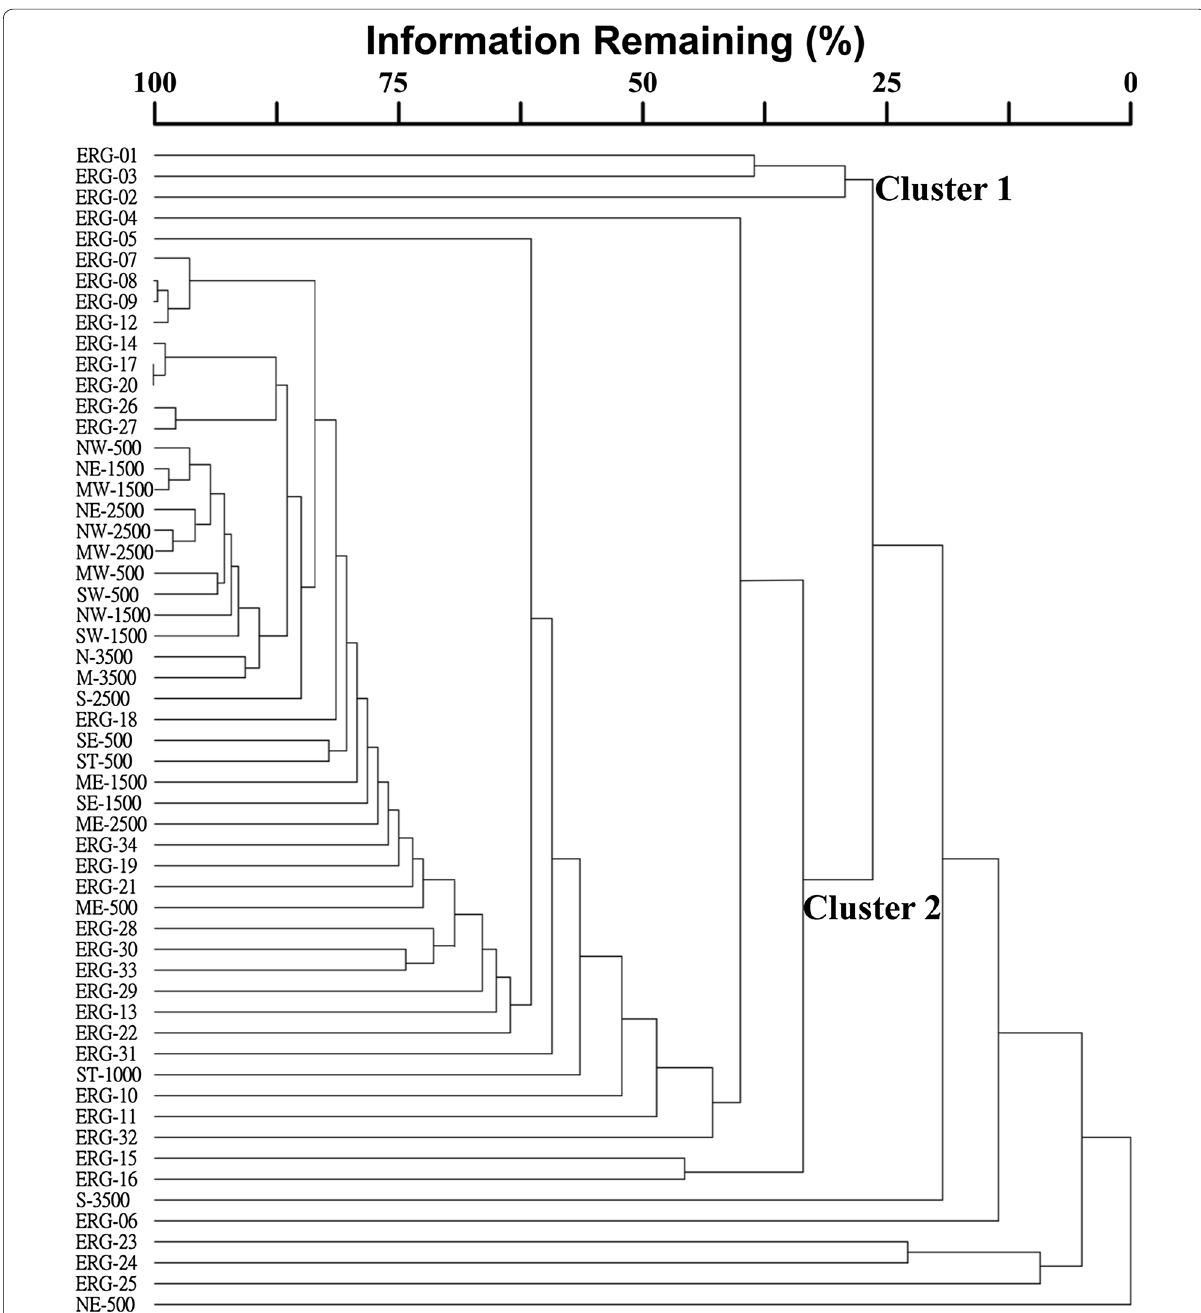
Fig. 4 Floristic relationships between 22 geographical localities of Taiwan (GLT) and 34 ecoregions in Asia were analyzed by cluster analysis, using simple nearest neighbor algorithm and Bray–Curtis dissimilarity method. Non‑endemic angiosperm species in Taiwan (NEAST) were used for the cluster analysis. The ecoregions of cold winter desert and temperate needle‑leaved forests were the first cluster and came out as the most deviating regions. The second cluster was comprised of many ecoregions and GLTs. Deep in the second cluster, tropical and subtropical ecoregions and some GLTs were grouped together. ERG is the acronym of ecoregion. The numbers after ERG and dash are the number of ecoregions listed in Table 1 and Fig. 2. The number and acronyms of 22 GLTs are the same as in Fig.